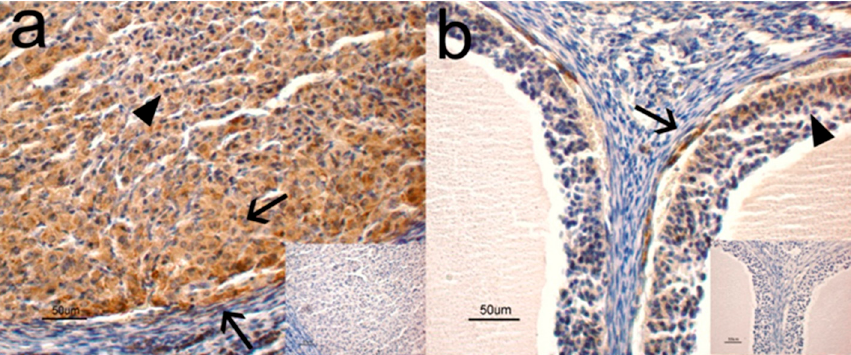
Figure 1. Nerve growth factor (NGF) immunoreaction (IR) in the ovaries of grey squirrels. ( a ) The positive signal is localized in the cytoplasm of small (arrowhead) and large (arrows) luteal cells. ( b ) The positive signal is localized in the cytoplasm of thecal (arrow) and granulose (arrowhead) cells. Bar = 50 µm.